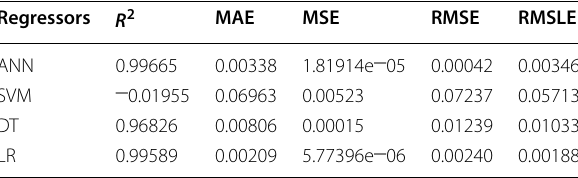
Table 2 Prediction performance of different